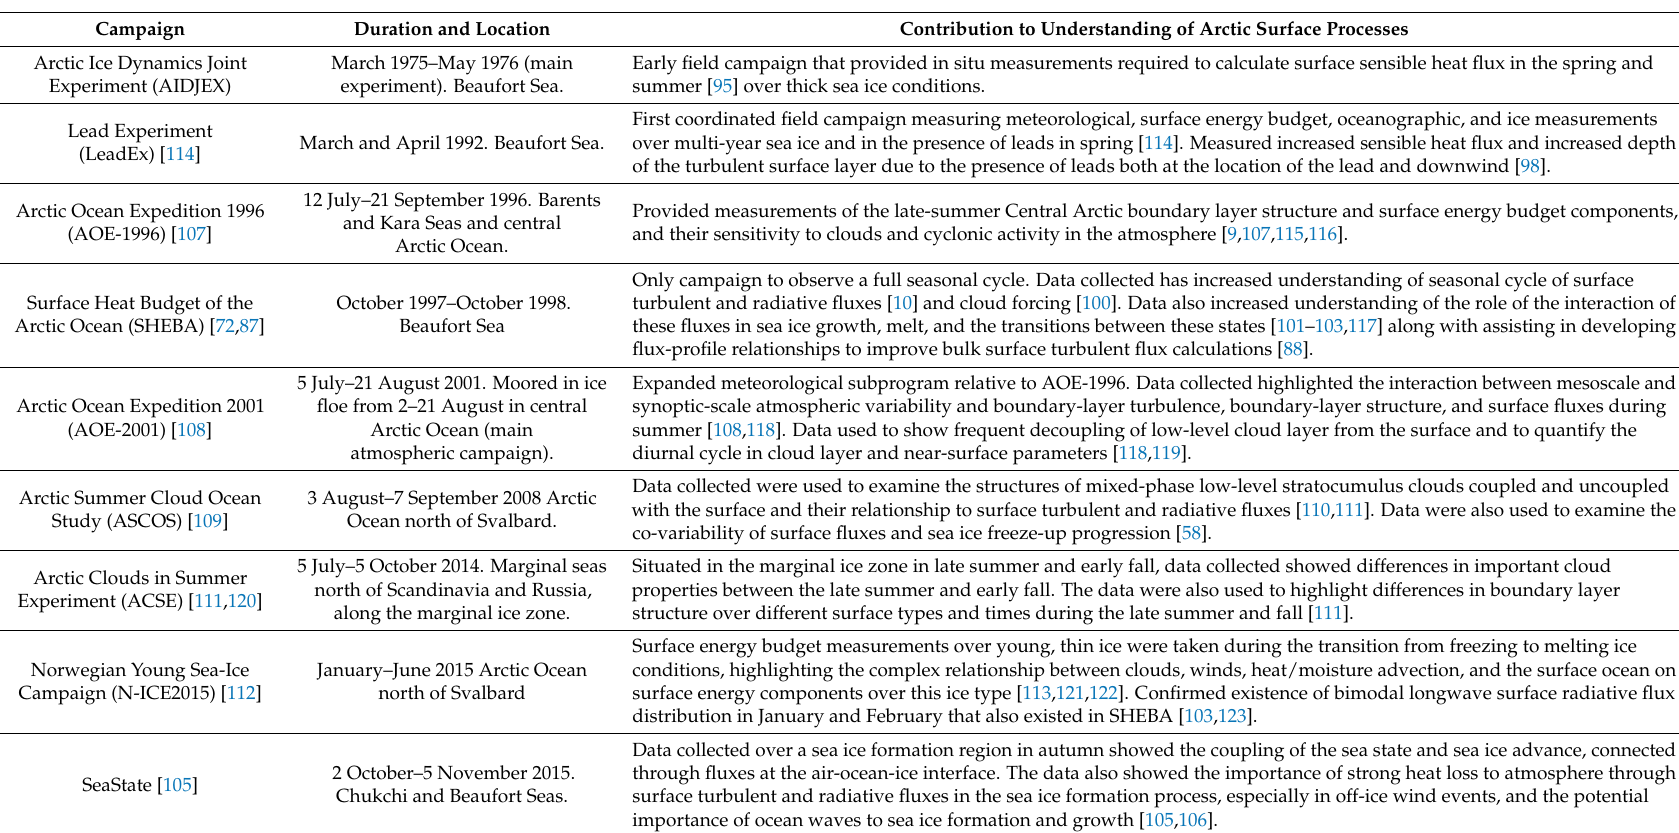
Table 1. List of major Arctic field campaigns measuring surface radiative and turbulent fluxes over sea